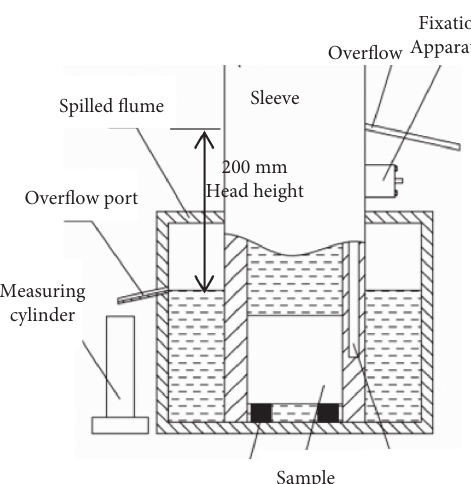
Figure 2: Schematic diagram of self-made constant water head permeability coefficient testing device.